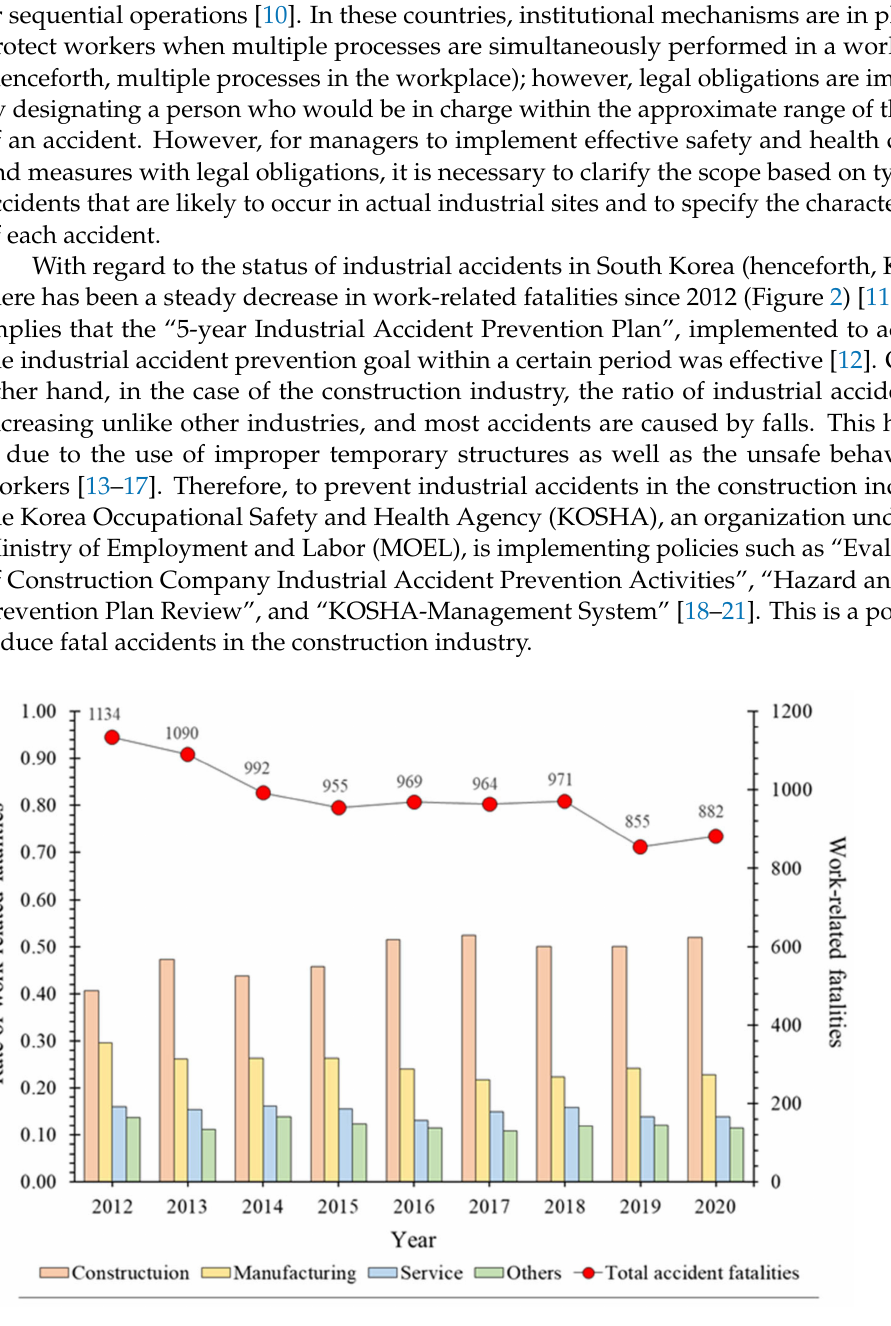
Figure 2. Annual number of fatalities and rate of fatalities in the